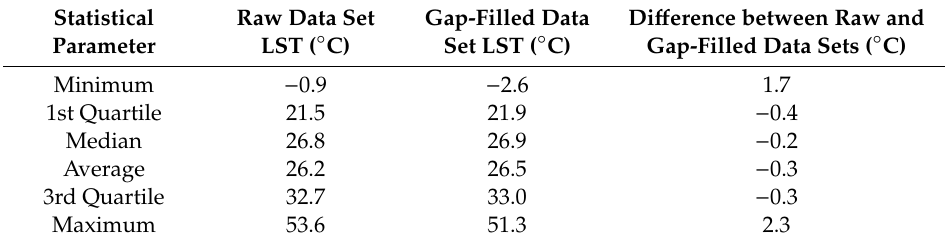
Table 4. Summary statistics of the raw and DINEOF gap-filled LST data sets.